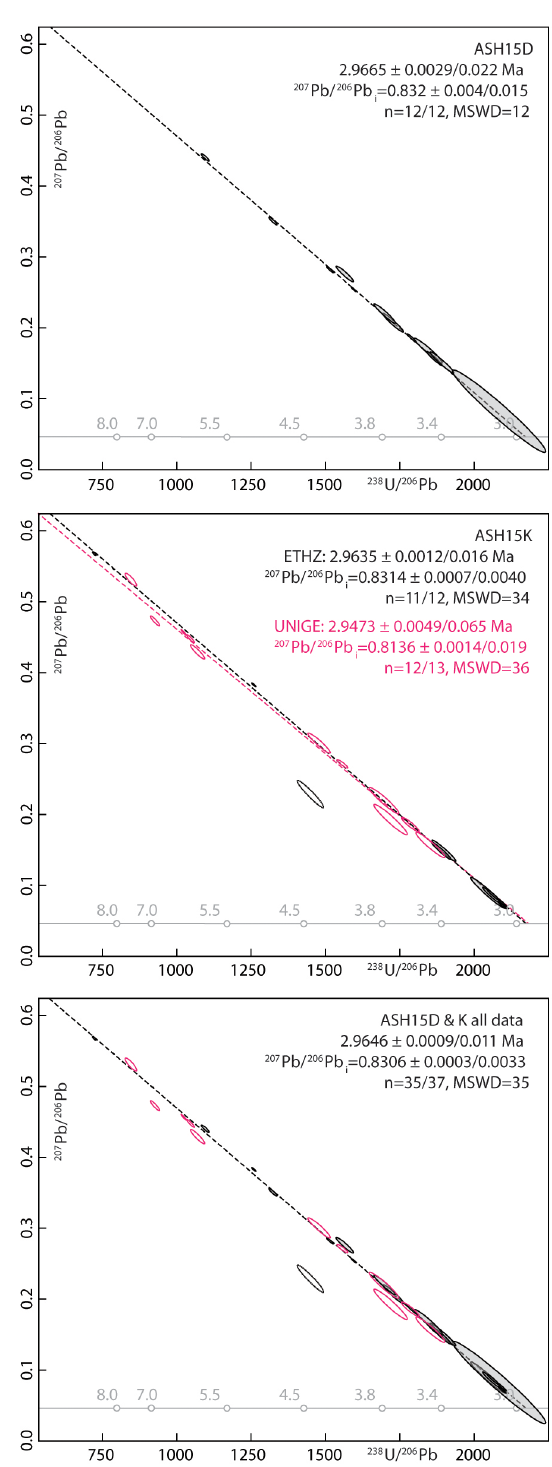
Figure 6. ID-TIMS U − Pb results for ASH-15D, ASH-15K, and for both ASH-15D+K displayed in Tera–Wasserburg concordia space. Uncertainties on the initial 207 Pb / 206 Pb ratios and the intercept ages are reported at 95% confidence including overdispersion (Ver- meesch,